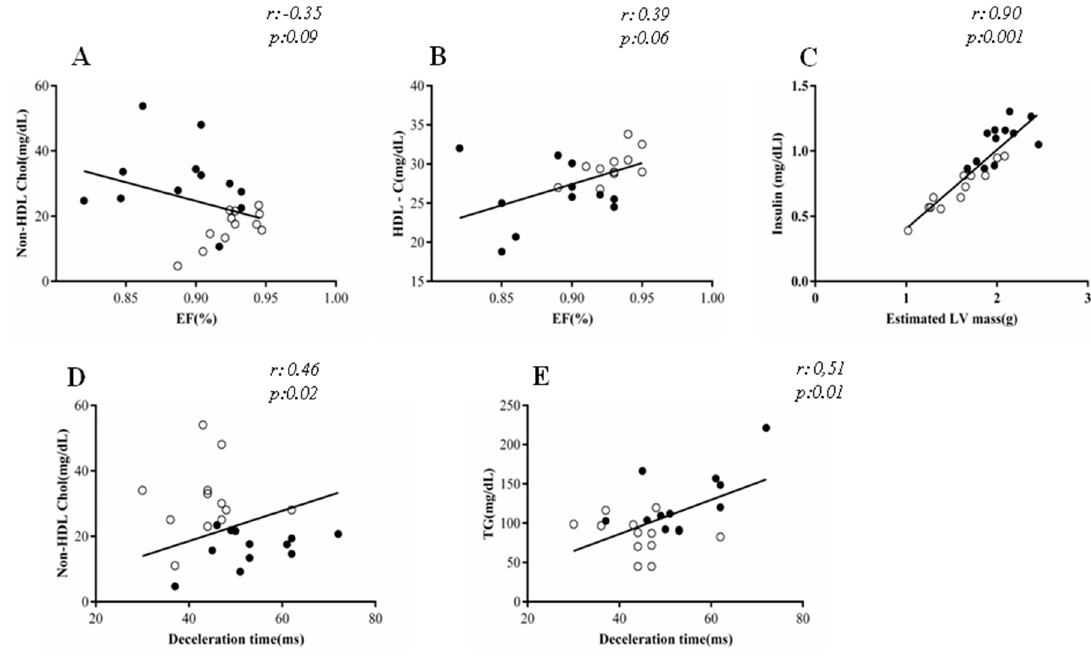
Figure 3. Correlation between echocardiographic and biochemical parameters. EF: Ejection Fraction; ( A) Non-HDL Chol:(mg/dL)/EF; ( B ) TG: HDL: High-density lipoprotein(mg/dL)/EF; ( C ) Insulin:(mg/dL)/estimated LV mass; ( D ) Non-HDL Chol:(mg/dL)/Decelaration time and ( E ) Triglycerides (mg/dL)/Decelaration time. Control group ( ○ ), HSF group ( ● ); Pearson regression was used to examine the associations between variables.